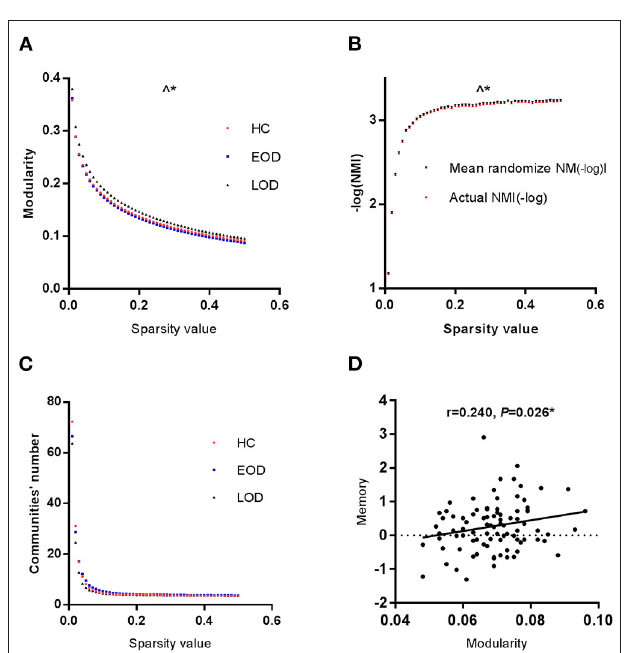
FIGURE 1 | (A) The modularity of the GC network was significantly different among the three groups. (B) The NMI between EOD and LOD was significantly different. Red lines represented the-log (NMI) between EOD and LOD group. The dashed lines represented the null distribution derived from the permutation analysis. (C) The module number was the same in the three groups. (D) Modularity and memory function were positively correlated in HC group. ∧ * P < 0.05 for the area under the curve of a range of sparsity thresholds. * P < 0.05.